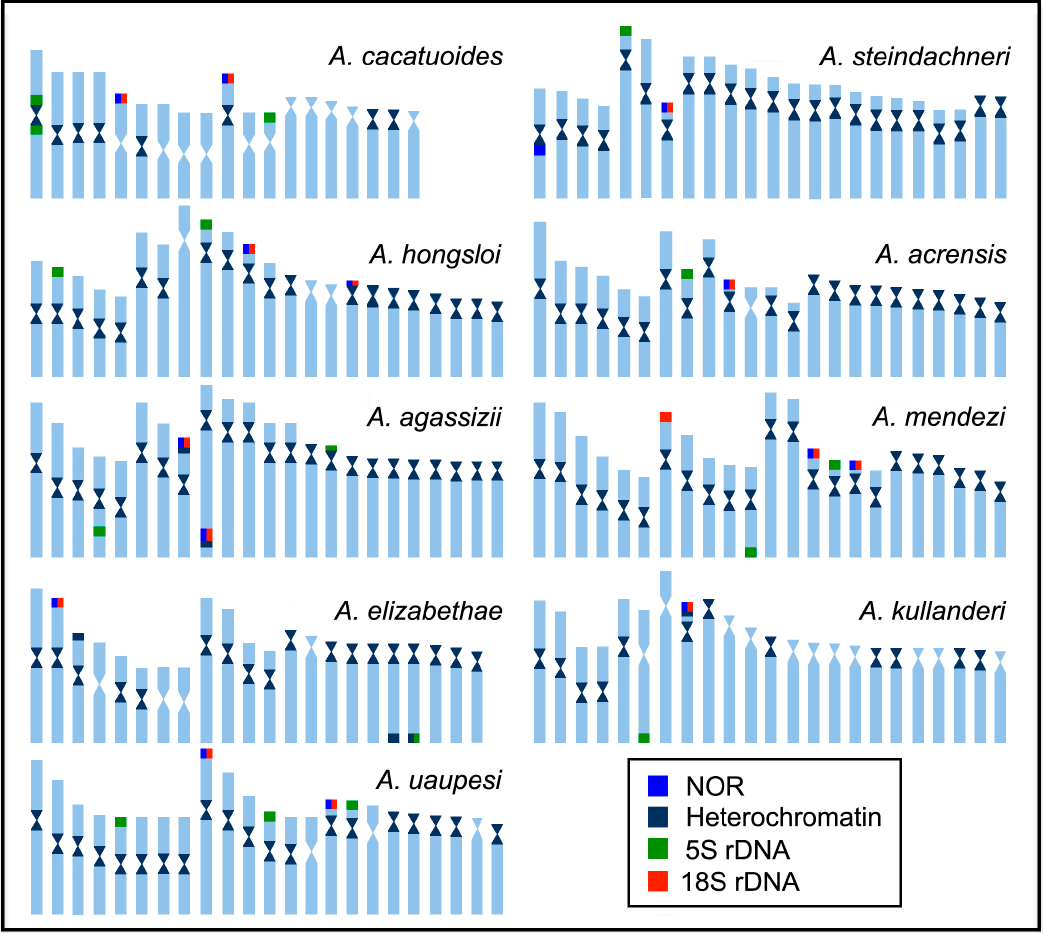
Figure 5. Idiograms detailing the karyotype structure and organization of rDNA sequences and heterochromatin in Apistogramma species.